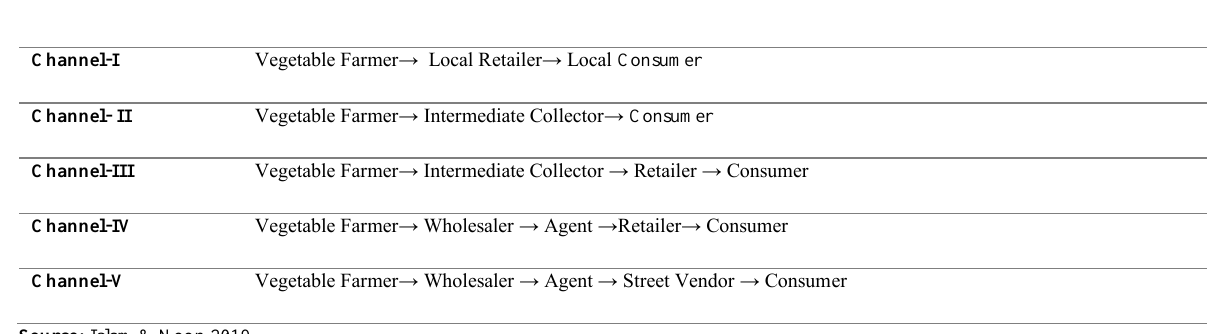
Table 1: Marketing channels of